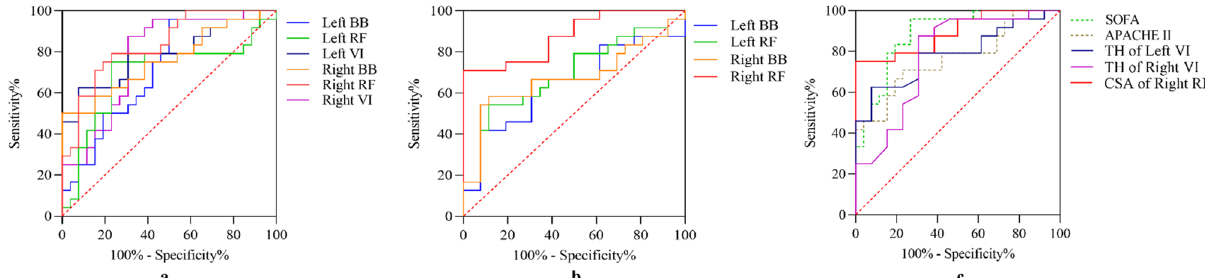
Figure 4. Comparison of ROC curves among SOFA score, APACH II score, ΔTH day10, and ΔCSA day10 of muscles. ( a ) Comparison of changes in TH of biceps brachii muscle, vastus intermedius muscle and rectus femoris muscles; ( b ) comparison of changes in CSA of biceps brachii muscle, vastus intermedius muscle, and rectus femoris muscles; ( c ) comparison among changes in TH and CSA of muscles, SOFA and APACHE II score. BB, biceps brachii; RF, rectus femoris; VI, vastus intermedius; TH, thickness; CSA, cross-sectional area; APACHE II, Acute Physiology and Chronic Health Evaluation II; SOFA, Sequential Organ Failure Assessment.